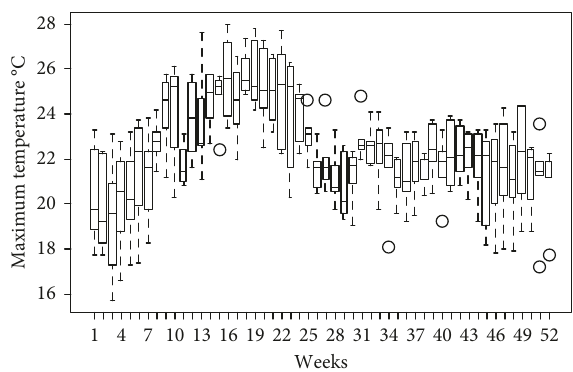
Figure 1: Box-plot for weekly maximum temperature registers, period: 2/09/2011–2/09/2017.